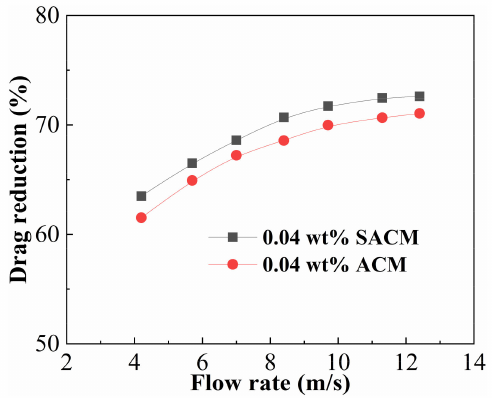
Figure 9. Drag reduction curves for suspension diluent and powder